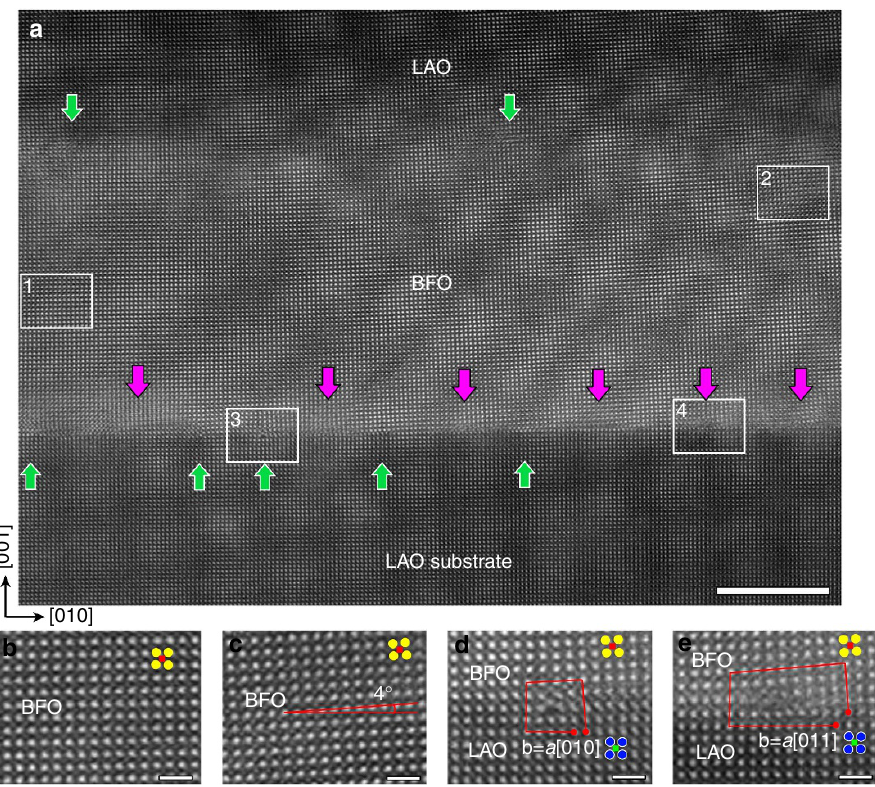
Figure 1 | HAADF–STEM images of the two-layer LaAlO 3 /BiFeO 3 /LaAlO 3 (001) nanostructures viewed along [100]. ( a ) Atomically resolved HAADF–STEM image. Scale bar, 10nm. Boxes labelled with numbers 1, 2, 3 and 4 are four typical areas magnified in b – e . Note the relative lattice rotation of c compared with b , which indicates a possible continuous lattice rotation in the BiFeO 3 nanostructures in a across the in-plane direction. Pink and green arrows in a indicate two different types of interfacial dislocations, as shown in d and e . The insets in b – e correspond to the unit-cell schematics of BiFeO 3 and LaAlO 3 (yellow circles, Bi; red squares, Fe; blue circles, La; green squares, Al; O is omitted here since it was not imaged because of its lower atomic number). All scale bars in b – e are